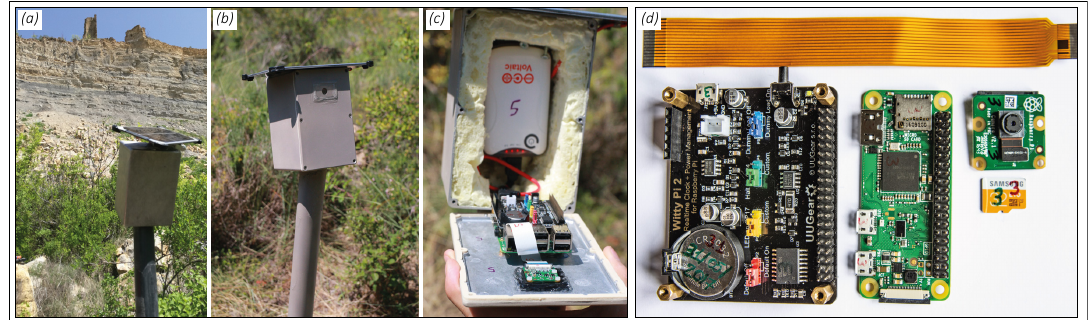
Figure 5. Low-cost photogrammetric systems developed ad-hoc for rockfall monitoring on the Puigcerc ó s cli ff . ( a , b , c ) Images of the installation on the Puigcercos cli ff . ( d ) Main electronic components (left to right): WittyPi2, Raspberry Pi Zero W, Raspberry Camera Module v2 and MicroSD